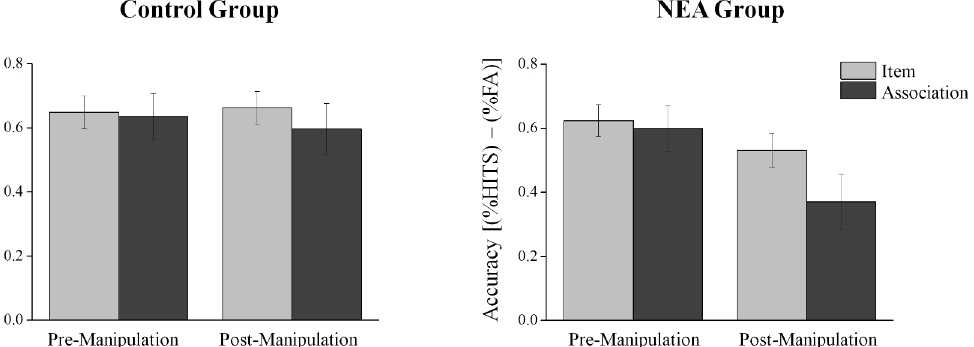
Fig 2. Behavioral results. Memory performance on items and the associative recognition tests in the pre-and post-negative emotional arousal (NEA) manipulation phases in each group. The measure used is proportion hits minus proportion false alarms (FA). Error bars represent the standard error of the